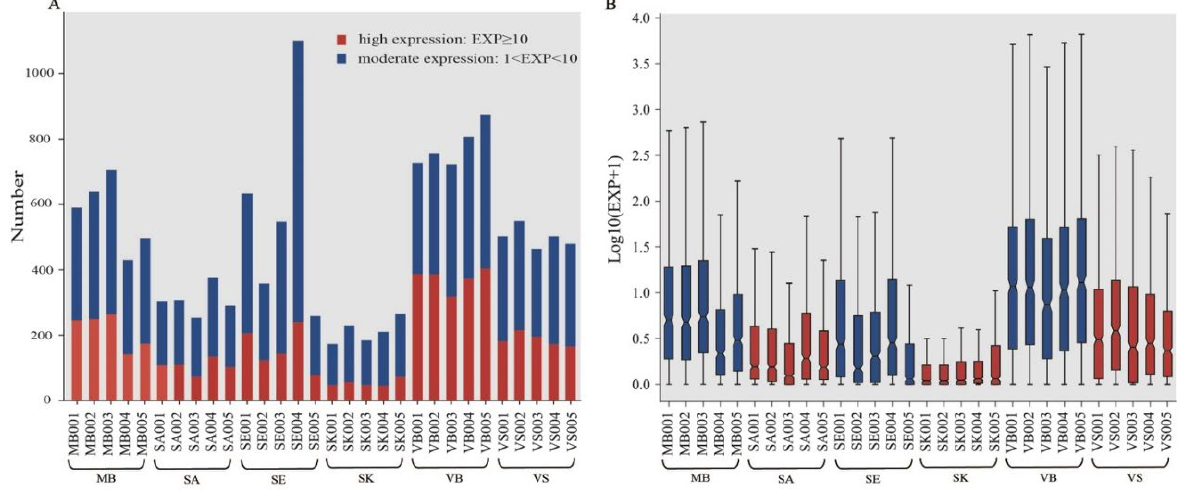
Figure 4. The expression distribution in 30 forensic related samples. ( A ) The number of markers with moderate and high expression level; ( B ) expression level of each sample (average EXP > 1 is presented). To further compare the expression level distribution, each RNA with an average expression of more than 1 EXP value was presented in Figure 4B, and the differences within and between groups were observed. Similar to the results of Figures 4A and S1, different